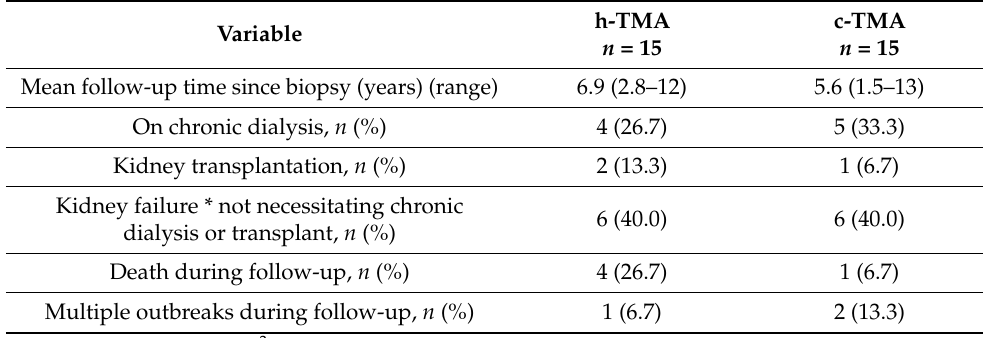
Table 6. Longitudinal changes from last follow-up. Reference values and units are given where appropriate. p -values were not